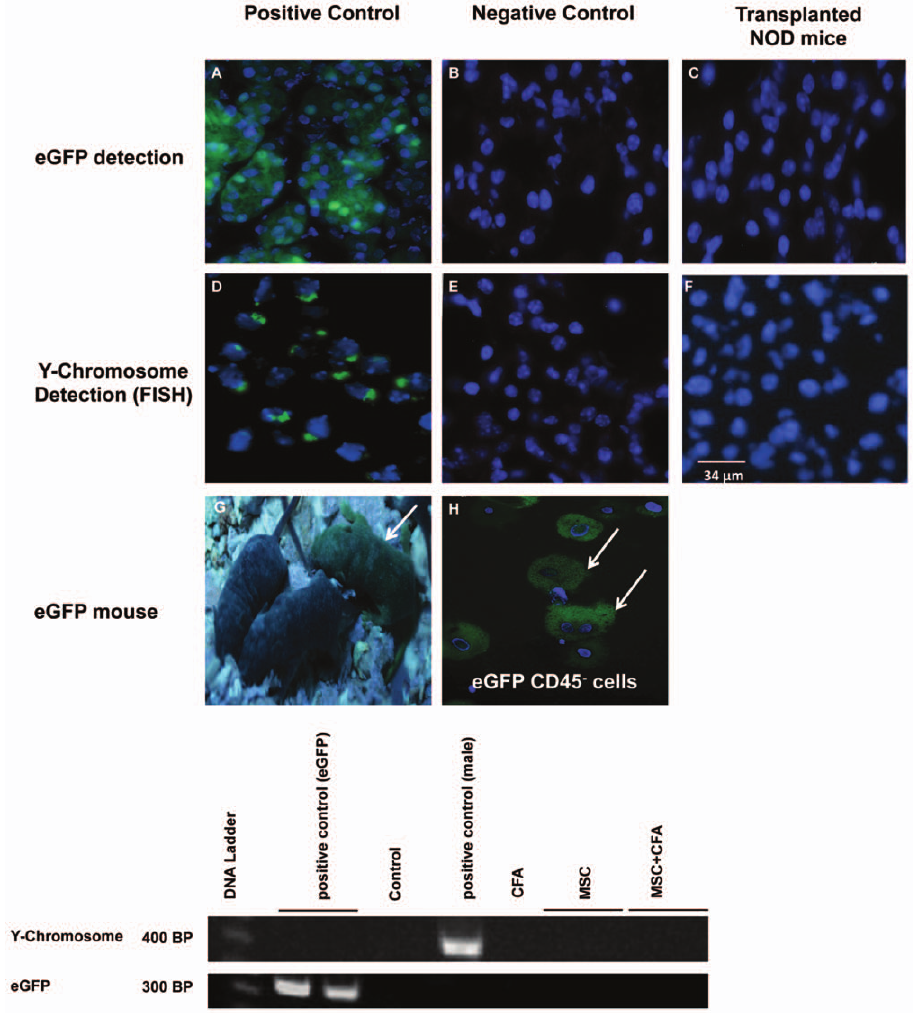
Figure 8. Absence of eGFP and male MSC (CD45 2 /TER119 2 ) donor cells in salivary tissues of female NOD mice. Top panel: eGFP detection of MSC donor cells by immunostaining. (A) Salivary tissues from the eGFP donor mouse (positive control) versus (B) the non-eGFP mouse (negative control). (C) NOD mice transplanted with MSCs were negative for eGFP cells. Middle panel: Y-chromosome detection of male MSCs by FISH. (D) male and (E) female salivary tissues used as positive and negative controls, respectively. (F) Female NOD mice transplanted with male MSCs showed no Y-chromosome signal in their salivary glands. Bottom panel: (G) CByB6F1-eGFP transgenic mouse (arrow) and (H) the isolated donor eGFP MSCs before transplantation. Cell nuclei are stained in blue (Hoechst 33258). (I) PCR amplification did not detect the Y-chromosome and eGFP signal in salivary glands of MSCs transplanted NOD mice (n=11).